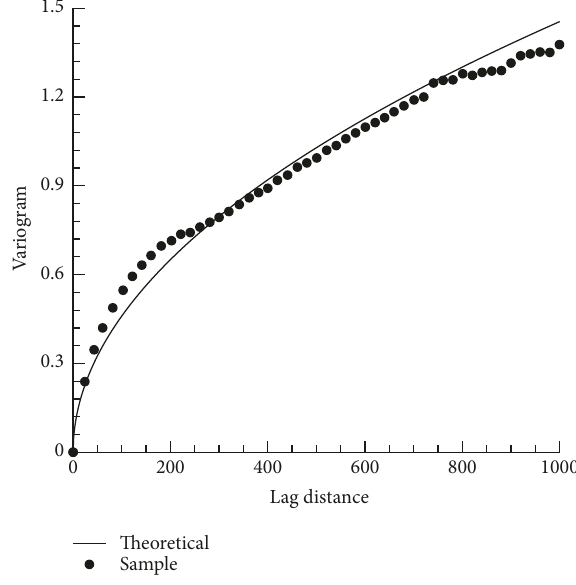
Figure 4: Comparison of the theoretical power variogram with parameters {𝐴 0 , 𝐻} = {0.046, 0.25} and its corresponding sample